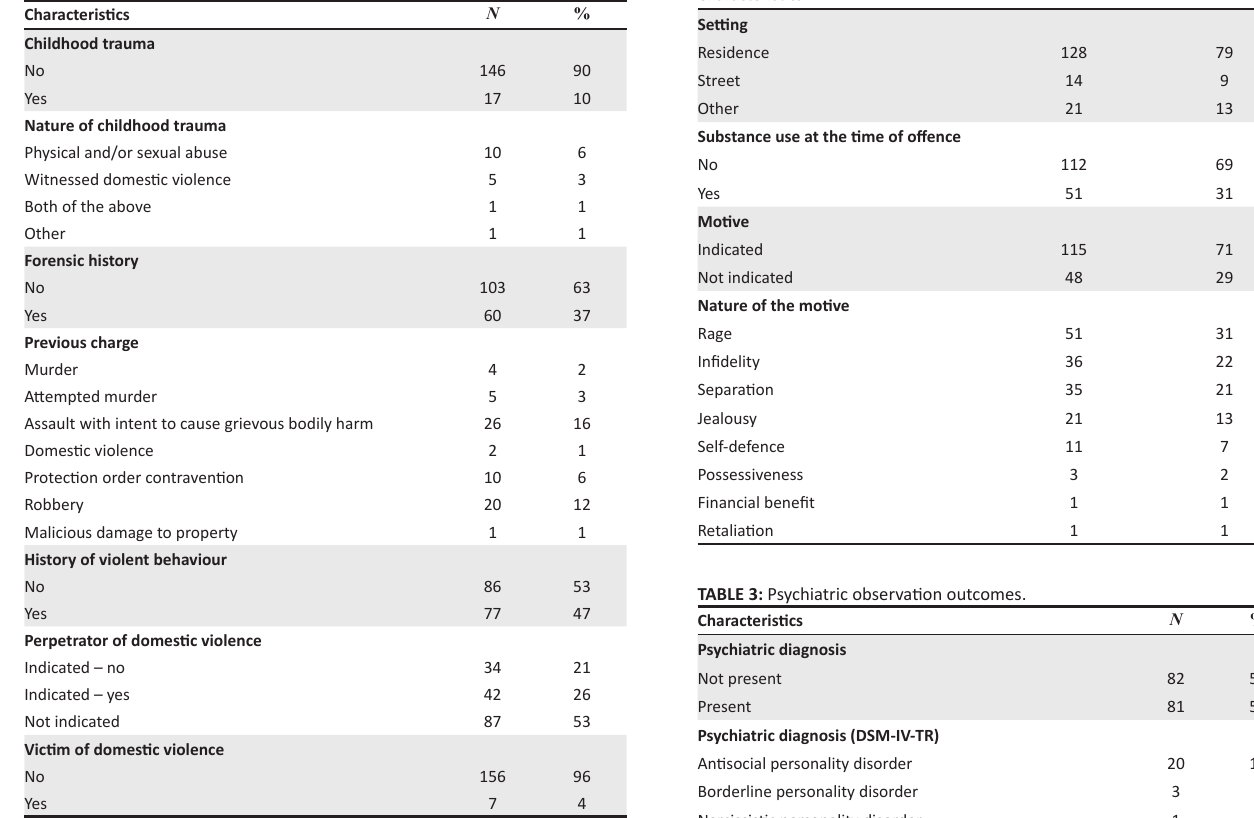
TABLE 1 (Continues...): Socio-demographic, clinical and forensic profile of accused persons.